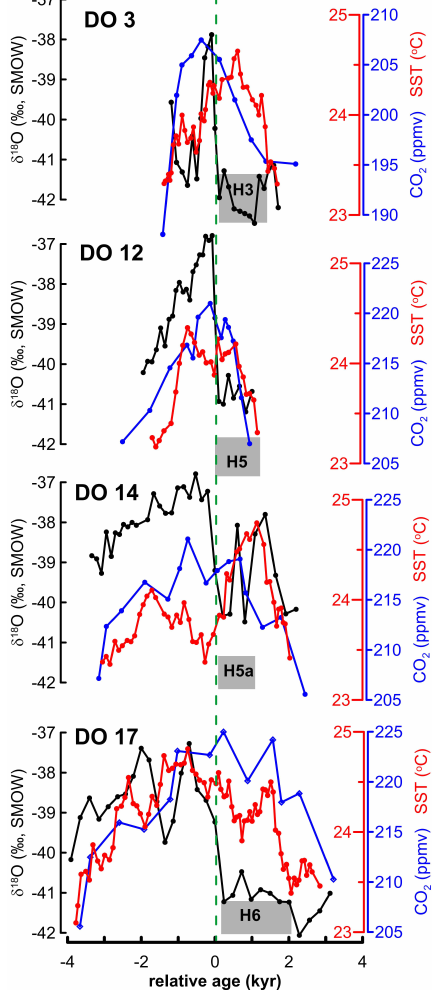
Fig. 6. 5-point running average of the EEA SST record (red) plot- ted relative to the timing of rapid air temperature warming over Greenland (green dashed line) during DO events, as indicated by the GISP2 record (Blunier and Brook, 2001) (black line), and at- mospheric CO 2 changes (blue) (Ahn and Brook, 2008). Gray bars indicate period of Heinrich